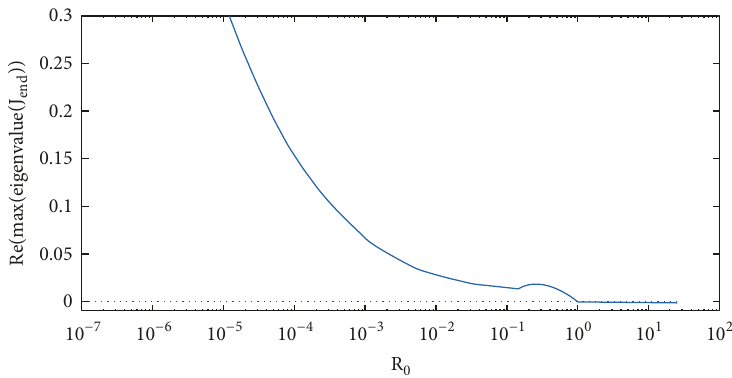
Figure 2: Maximum real part of the eigenvalues versus the reproduction